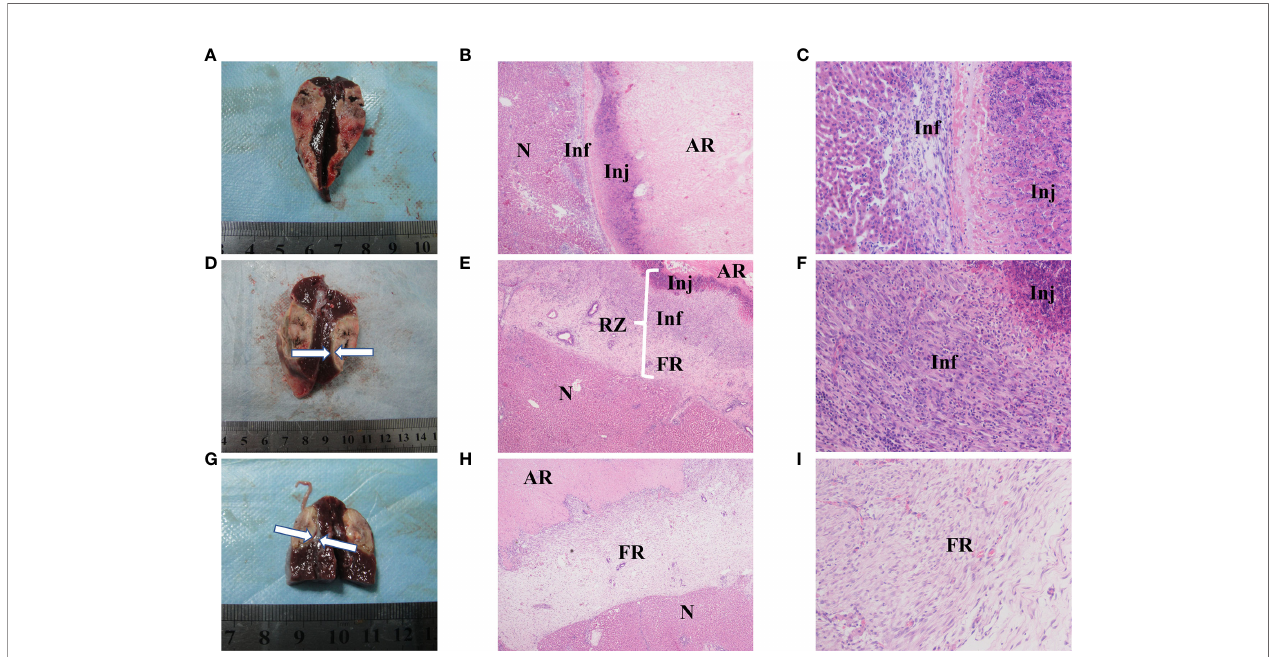
FIGURE 6 | Gross morphology and histological images of benign radiofrequency ablation (RFA) region. The areas represented from peripherial to central ablation are as follows: normal hepatocyte (N); reaction zone (RZ); ablation region (AR). (A – C) (on day 3 after RFA): Ablation lesion was shown as well circumscribed, gray-white tissue in gross morphology observation (A) , in which AR and RZ cannot be distinguished obviously. 40× H&E histology (B) showed AH was dominated by coagulation necrosis. RZ was observed at the periphery of AR, mainly consisted by injury reaction (Inj) and in fl ammatory (Inf). 200× H&E histology (C) showed that Inj was mainly composed of hepatocytes with pyknosis and karyorrhexis, and Inf was manifested as small amount of in fl ammatory cell in fi ltration. (D – F) (on day 7 after RFA): Gross morphology image (D) : granulation tissue around the ablation lesion can be observed (white arrows); 40× (E) H&E histology showed the change of RZ, in which Inj shrank while the in fl ammatory (Inf) and fi brosis increase, and a fi brous rim (FR) had formed in periphery. (F) showed Inj and Inf in 200× H&E histology. (G – I) (on day 14 after RFA): Gross morphology image of day 14 after RFA (G) : granulation tissue around the ablation lesion had gotten thicker and denser (white arrows); 40× (H) and 200× (I) H&E histology showed Inj and Inf were signi fi cantly reduced and even disappeared in some area, RZ was mainly composed by a further thickened FR.